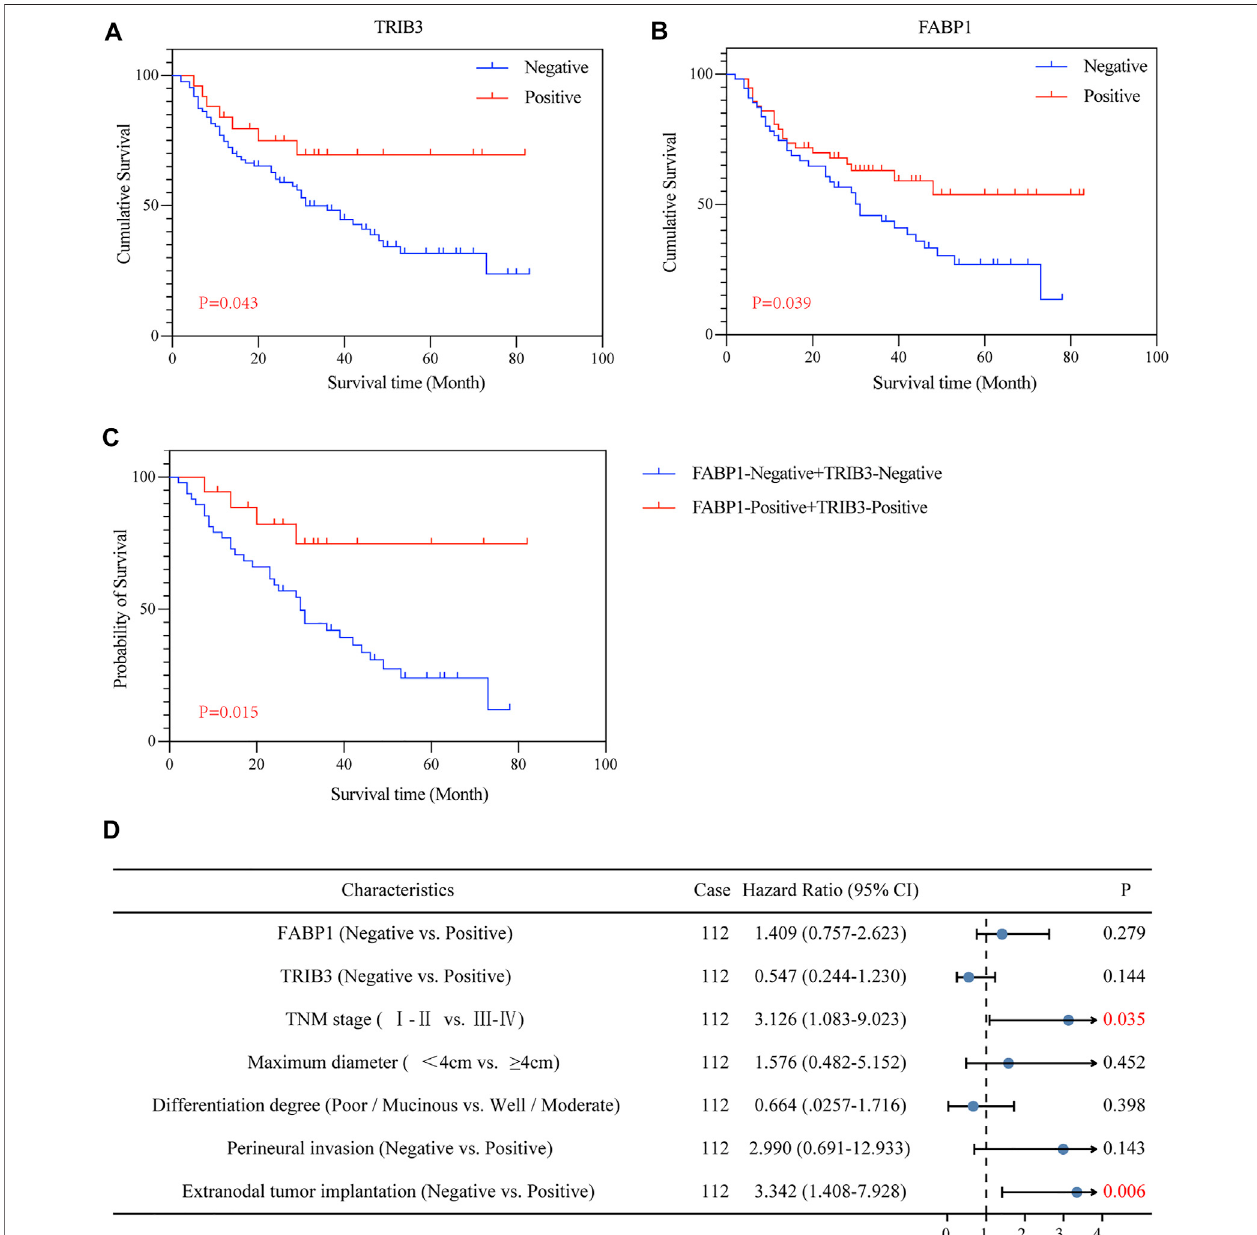
FIGURE4| TheprognosticvalueofTRIB3 and FABP1forAGC.Theprotein expressions ofTRIB3 (A) andFABP1 (B) tended tohave bettersurvivalincomparison to those negative. Besides, patients with both positive expression of TRIB3 and FABP1 tended to have superior survival time compared with the both negative patients (C)